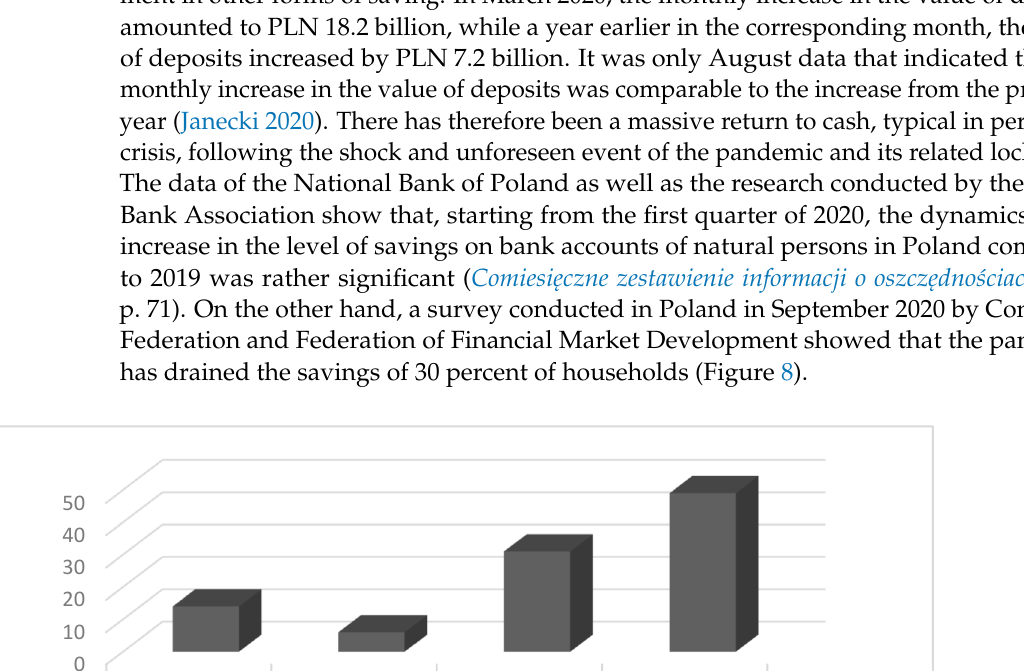
Figure 7. Household saving rate. Lack of sufficient data for Slovakia. Source: (Eurostat Database 2021; OECD Database 2021).